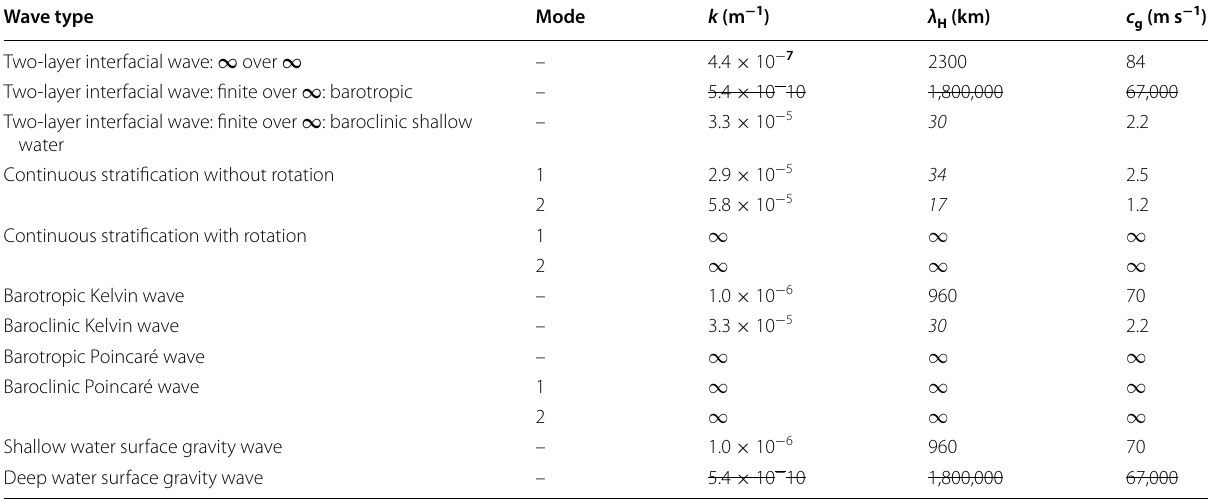
constituent (period 23.94 1 =